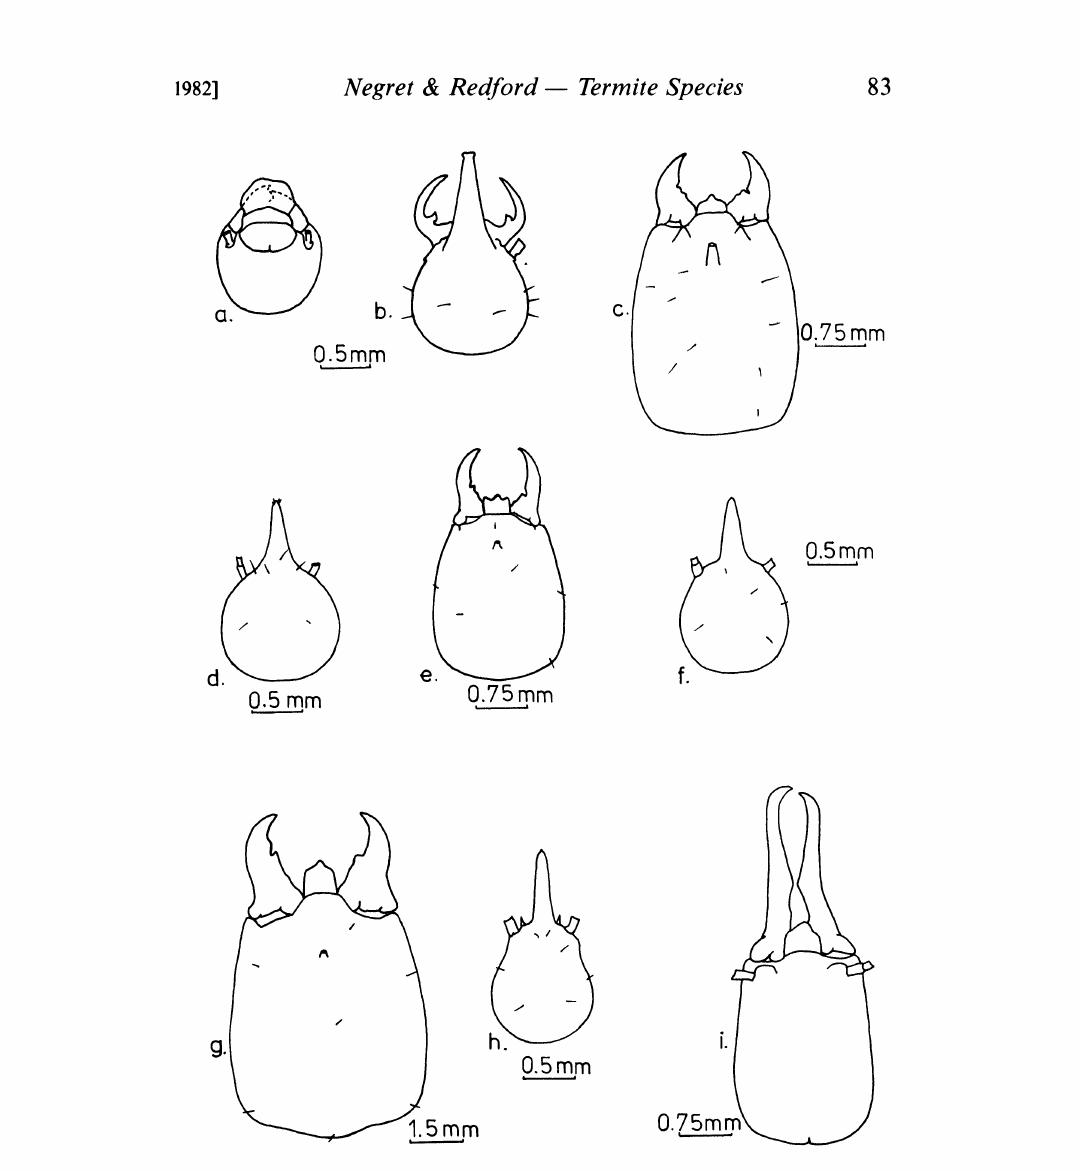
Figure 1. Soldier heads of eight of the species of termites studied; Grigiotermes metoeeus worker included for comparison: a, Grigiotermes metoecus; b, Armiter- mes euamignathus; c, Cornitermes cumulans; d, Cortaritermes silvestri; e, Pro- eornitermes araujo# f, Nasutitermes sp.; g, Syntermes dirus; h, Veiocitermes paucipilis; i, Orthognathotermes